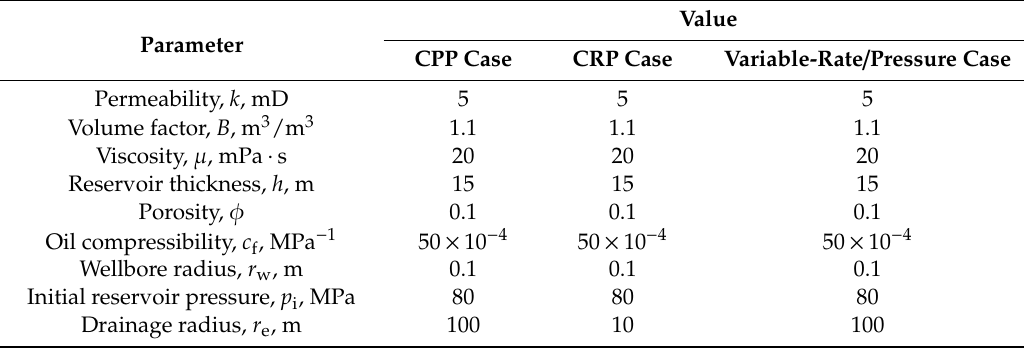
Table 3. Data used for the simulated cases.